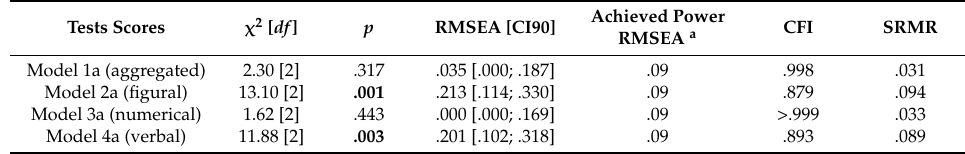
RMSEA = Root Mean Square Error of Approximation, CFI = Comparative Fit Index, SRMR = Standardized Root Mean Square Residual; a = for H 0 : RMSEA ≤ .06 against H 1 : RMSEA = .08, with α = .05.